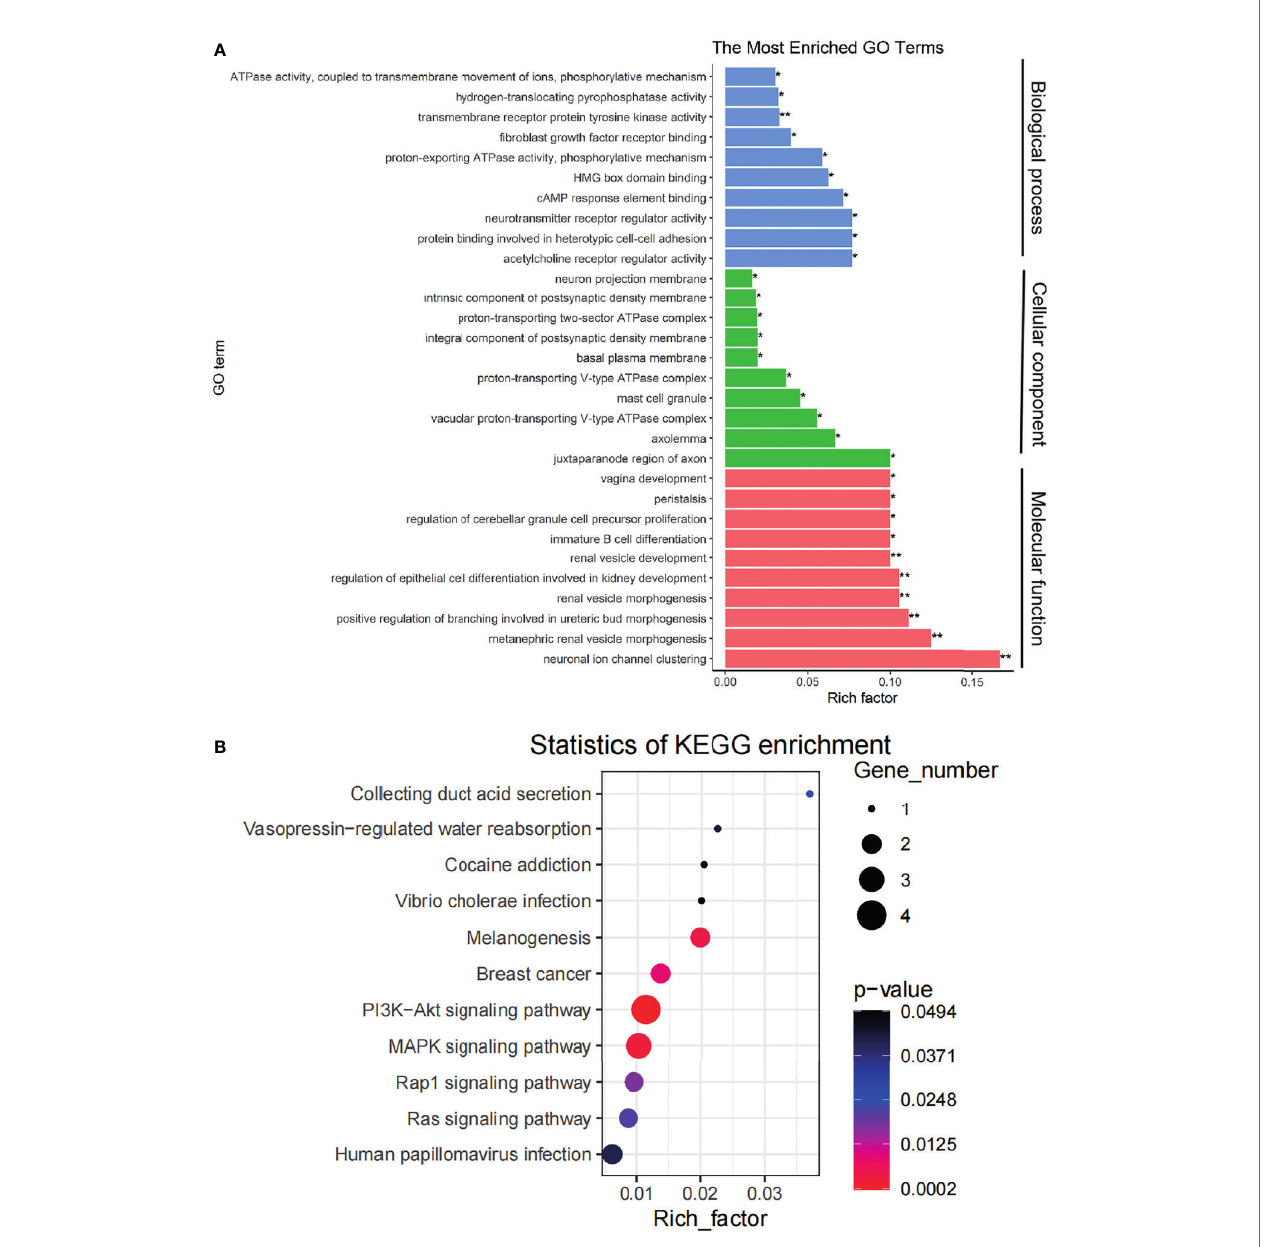
FIGURE 3 | The signaling pathways affected by genes in the ceRNA network are identi fi ed. (A) A plot showing the signaling pathways affected by genes in the ceRNA network as detected via GO enrichment analyses. (B) A bubble chart showing the signaling pathways affected by genes in the ceRNA network as detected via KEGG pathways analysis. ceRNA, competing endogenous RNA; GO, Gene Ontology; KEGG, Kyoto Encyclopedia of Genes and Genomes. *p < 0.05, **p <